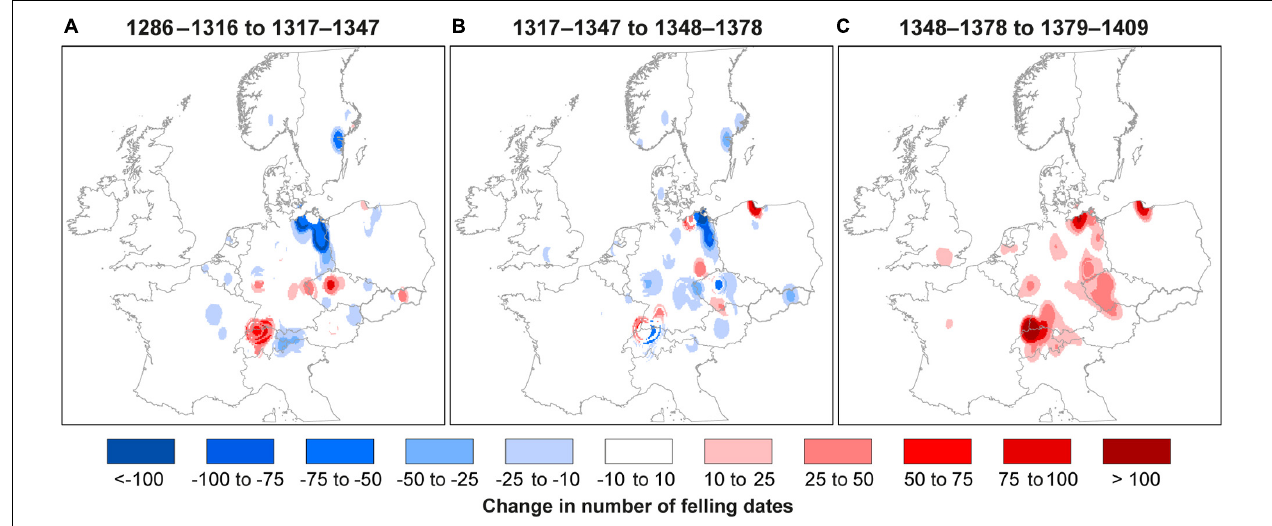
FIGURE 5 | Changes in the number of felling dates for four 31-year periods around the time of the Late Medieval Crisis. (A) Between 1286–1316 and 1317–1347, (B) Between 1317–1347 and 1348–1378, (C) Between 1348–1378 and 1379–1409. The maps are shown with contemporary political